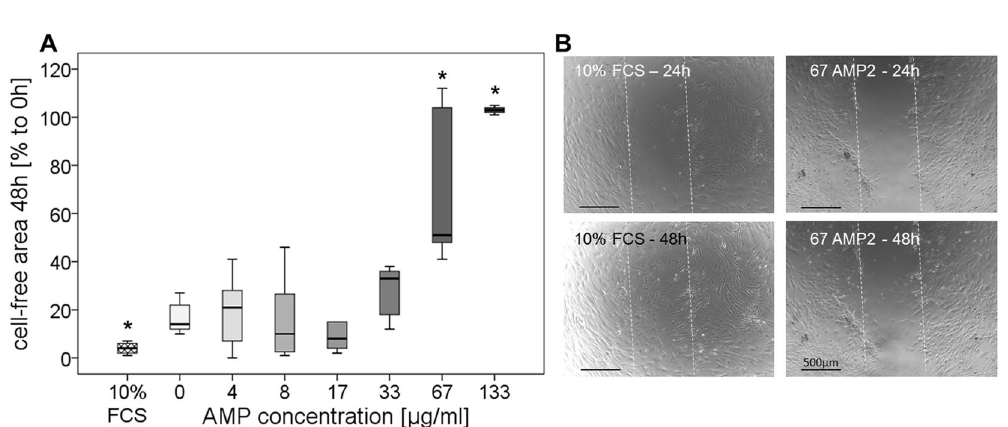
Figure 3. The differentiation experiment of the osteoblast-like cells was done with cultivation medium (CM), differentiation medium (DM) and DM with low (17 µ g/ml) and high (133 µ g/ml) AMP2. After 21 days alkaline phosphatase (AP) activity assay and staining (A) and alizarin red staining and quantification (B) were done (n = 6, cells from two donors, triplicates). Results were normalized to 10 4 cells and expressed in percentage to control (DM) which was set 100%. Data are shown as median with 25 and 75 percentiles. Kruskal-Wallis, Mann- Whitney, Bonferroni-Holm post-hoc test: * Significant difference compared to the DM group, p ≤ 0.05 . (C) Gene expression at days 0, 7, 14 and 21. Results are calculated with the ΔΔ Ct method with efficiency correction and normalization to the control (day 0 of differentiation) and 18 S ribosomal RNA used as a reference gene (n = 2). Data are shown as means with standard deviation.